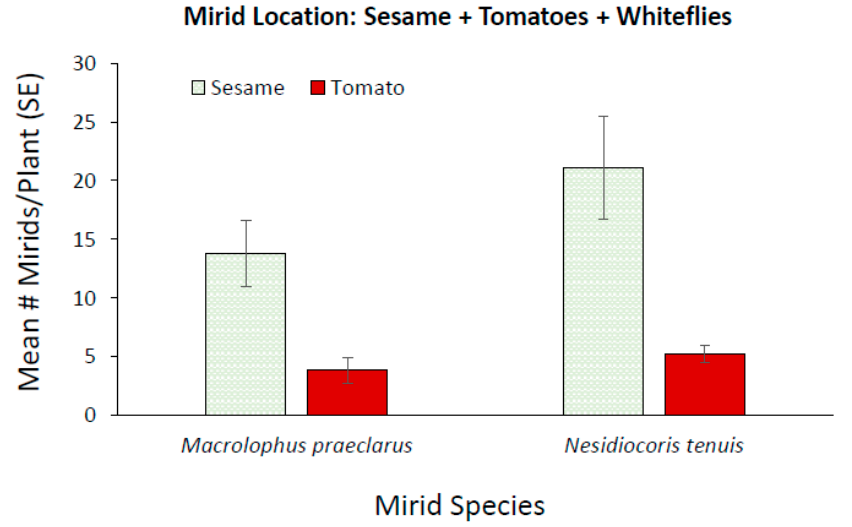
Figure 7. Mean (±SE) number of Macrolophus praeclarus and Nesidiocoris tenuis adults and nymphs found on whitefly infested tomato and sesame plants 5 weeks after adding adult mirids to field cages.